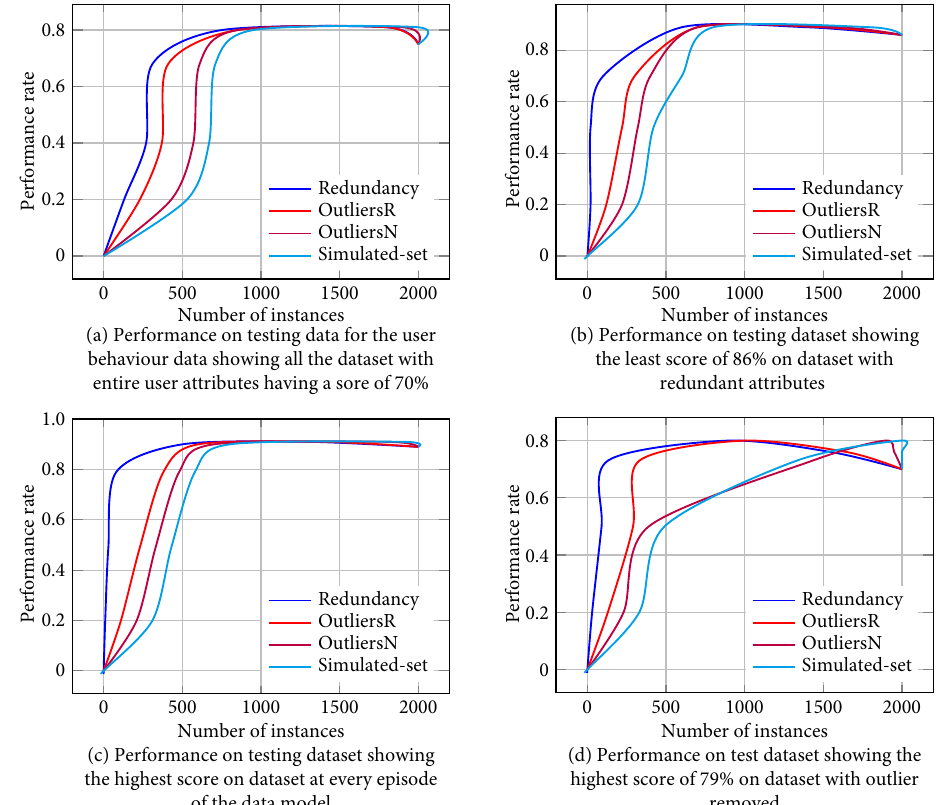
Fig. 6 Performance on dataset for both training and test sets showing scores for four different test